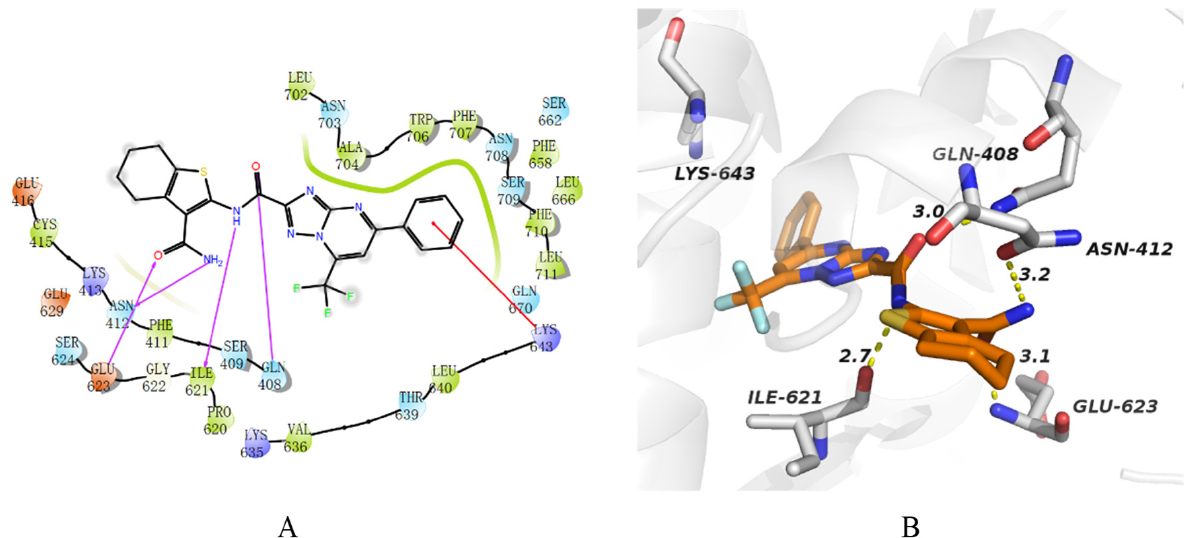
Figure 8. Docking model of H02 in the active site of RNA polymerase (PDB ID: 3CM8). ( A ) The two-dimensional (2D) diagrams of the interactions between H02 and 3CM8. The hydrogen-bond interactions with residues are represented by a purple dashed arrow directed towards the electron donor. The Pi-cation interactions with residues were represented by the red line. ( B ) The three-dimensional (3D) diagrams of the interactions between H02 and 3CM8. The hydrogen-bond interactions with residues were represented by a yellow dashed line.